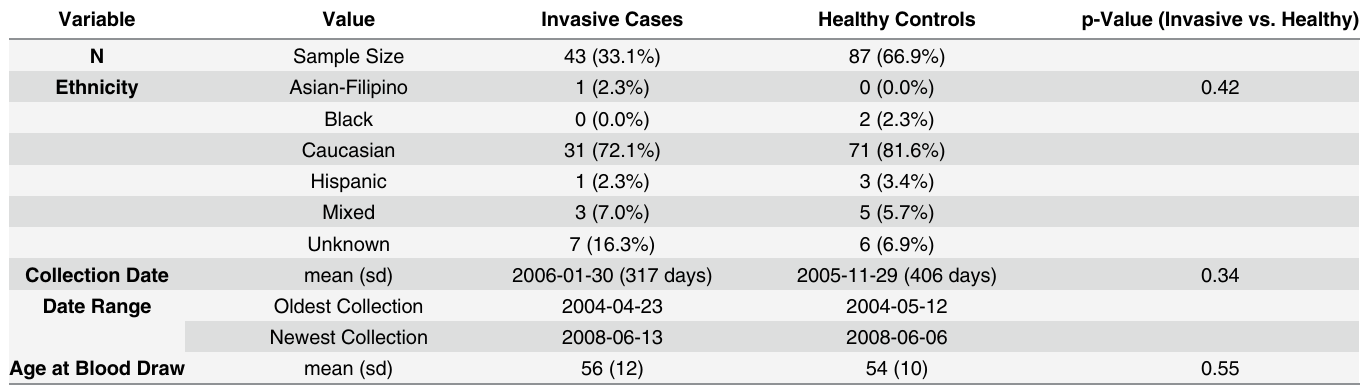
Table 1. Matching Cases to Controls.